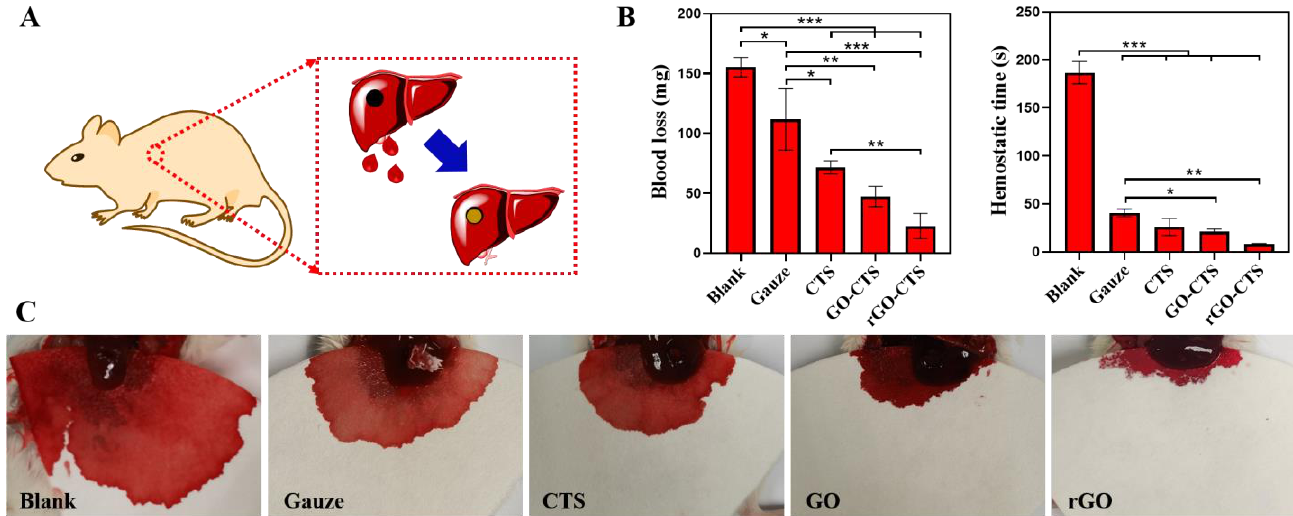
Figure 7. The hemostatic performance of the CTS, GO-CTS, and rGO-CTS cryogels in mouse liver trauma models. ( A ) Schematic image of the mouse liver trauma model; ( B ) blood loss and hemostatic time in the mouse liver trauma model; ( C ) photographs of in vivo hemostasis using hemostatic agents applied in cylindrical wounds of mouse liver as a non-compressible wound model, * p < 0.05, ** p < 0.01, *** p < 0.001.